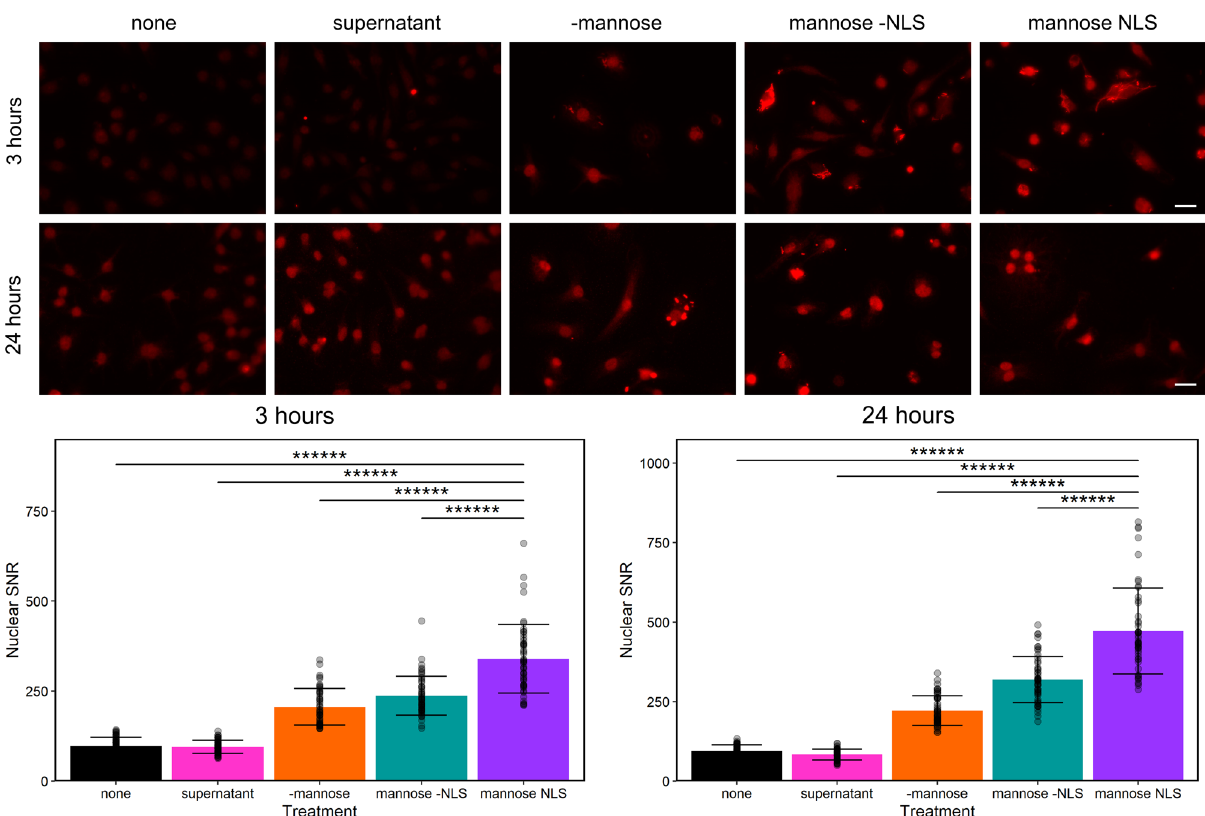
Fig. 4 Intracellular localization of LLO-lacZ secreted β -gal. The presence of β -gal in the nuclei of host cells was determined by measuring fl uorescent signals of anti- β -gal in the nuclei compared to background signals as a ratio (SNR). Fluorescence microscopy (top) and SNR (bottom) of the following: J774A.1 cells with no LLO strain (none), J774A.1 cells incubated with β -gal collected as supernatant from induced LLO- lacZ -NLS (supernatant), J774A.1 cells incubated with uninduced LLO- lacZ -NLS (-mannose), J774A.1 cells incubated with induced LLO- lacZ -no NLS (mannose -NLS) and J774A.1 cells incubated with induced LLO- lacZ -NLS (mannose NLS). Plotted data is mean ± SD from n = 50 random individuals from a representative experiment; ****** p < 0.000001. Scale bars = 20 µ